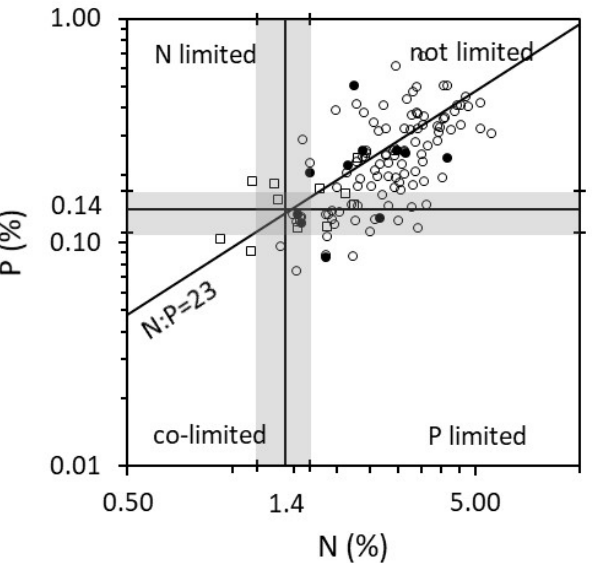
Figure 3. Tissue nutrient concentrations (% dry weight) from (i) the shoots of Juncus bulbosus (filled circles) and associated species (open circles) collected in Scotland during the summer across all types of aquatic habitats ( n = 102 samples [14]); (ii) 12 species of hydrophytes and helophytes (open squares) from oligotrophic Spanish lakes [36]. Species list from Scotland with the number of samples (corresponding to the number of datapoints per species on the graph): Callitriche hamulata (8), Isoetes lacustris (4), Juncus bulbosus (11), Littorella uniflora (11), Lobelia dortmanna (5), Myriophyllum alterniflorum (13), Potamogeton alpinus (2) P. natans (18), P. polygonifolius (12), Sparganium angustifolium (12), Subularia aquatica (1), Utricularia intermedia (2) Utricularia vulgaris sensu lato (3). Same nutrient threshold as Figure 2.